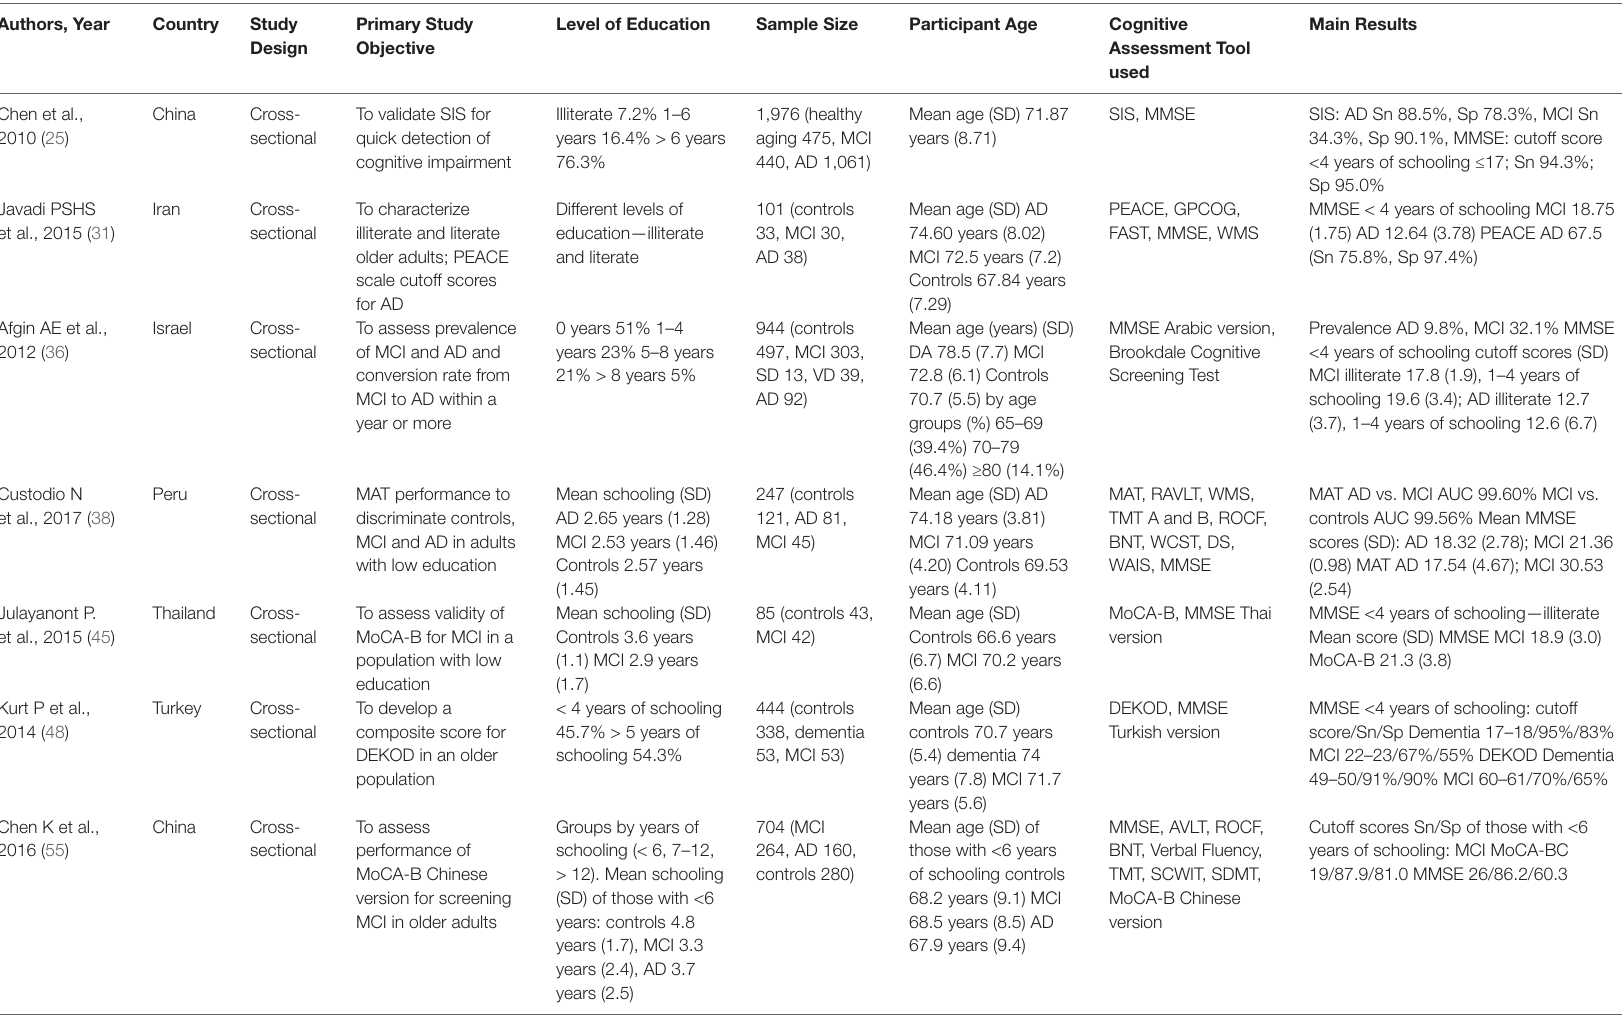
SIS, Six-Item Screener; MMSE, Mini-Mental State Examination; PEACE, Persian Test of Elderly for Assessment of Cognition and Executive function; GPCOG, General Practitioner assessment of Cognition; FAST, Functional Assessment Staging; WMS, Wechsler Memory scale; MAT, Memory Alteration Test; RAVLT, Rey-Auditory Verbal Learning Test; TMT, Trail Making Test; BNT, Boston Naming Test; ROCF, Rey-Osterrieth Complex Figure; WCST, Wisconsin Card Sorting Test; DS, Digit Span; WAIS, Wechsler Adult Intelligence Scale–Revised; MoCA, Montreal Cognitive Assessment; MoCA B, MoCA Basic; DEKOD, Dokuz Eylül Kognitif Degerlendirme/Dokuz Eylul Cognitive Assessment; SCWIT, Stroop Color-Word Interference Test; AUC, Area Under the ROC Curve; AVLT, Auditory Verbal Learning Test; SDMT, Symbol Digit Modalities